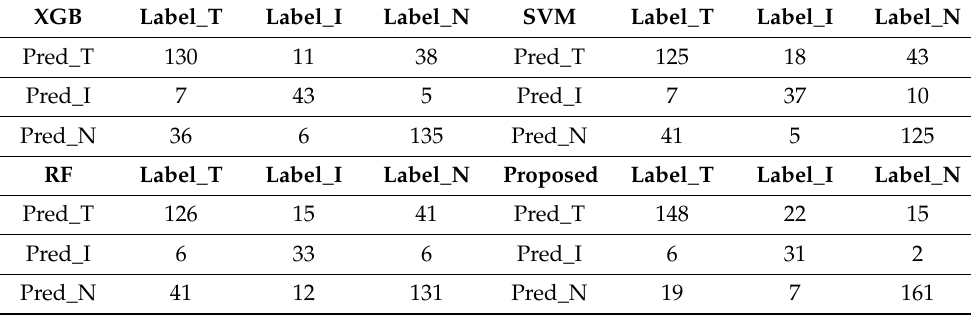
Table 3. Confusion matrices of machine learning.